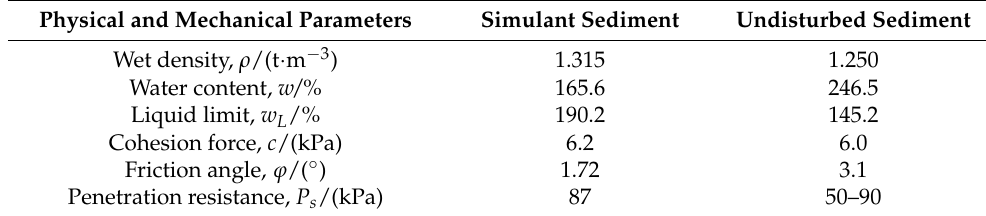
Table 1. Main physical and mechanical parameters of sediment.